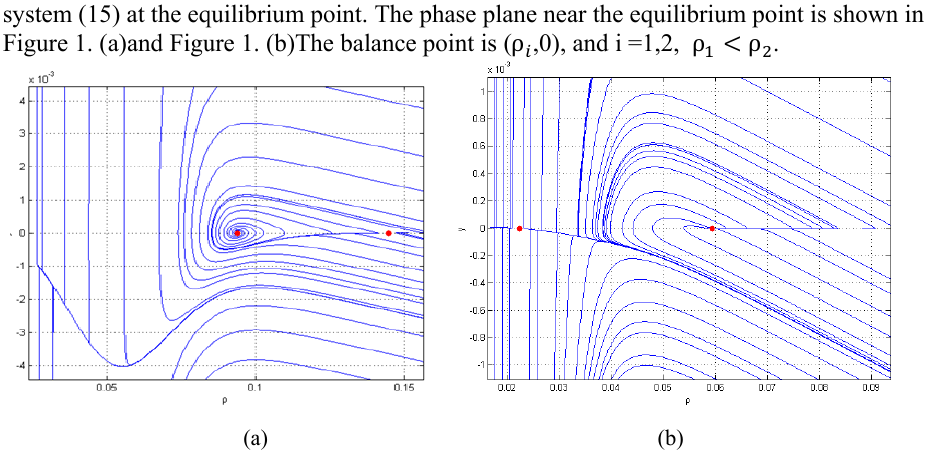
Fig. 1. Phase plane y-  trajectory diagram, (a) where traveling wave velocity 371.1  c , traveling wave parameter 𝑞 ∗ = 0.2 .(b) where traveling wave velocity 38.1  c , traveling wave parameter 𝑞 ∗ =